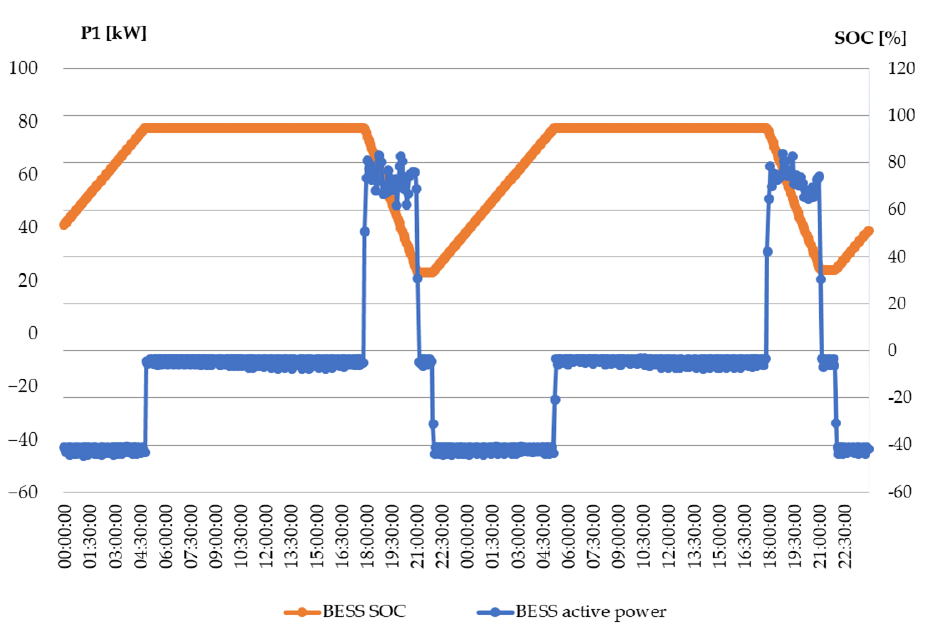
Figure 6. BESS active power (P1) and SOC dynamics on 7 April and 8 April 2021.